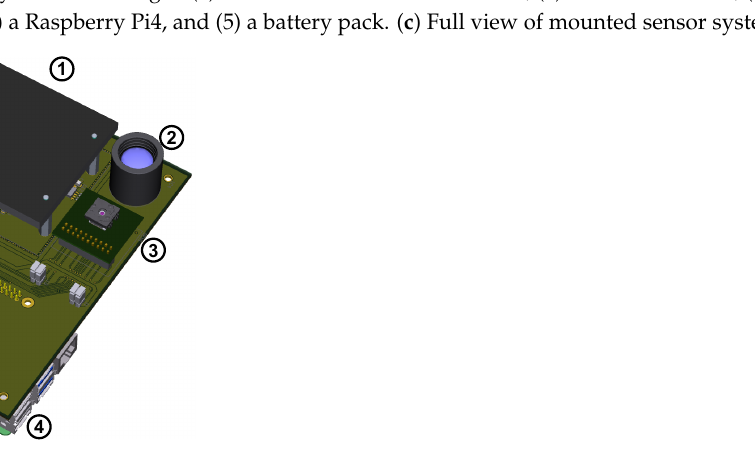
Figure 2. Rendering of the extended prototype, showing (1) radar, (2) 80 × 64 pixel LWIR sensor, (3) 160 × 120 pixel LWIR sensor, (4) Raspberry Pi 4, and (5) power supply and